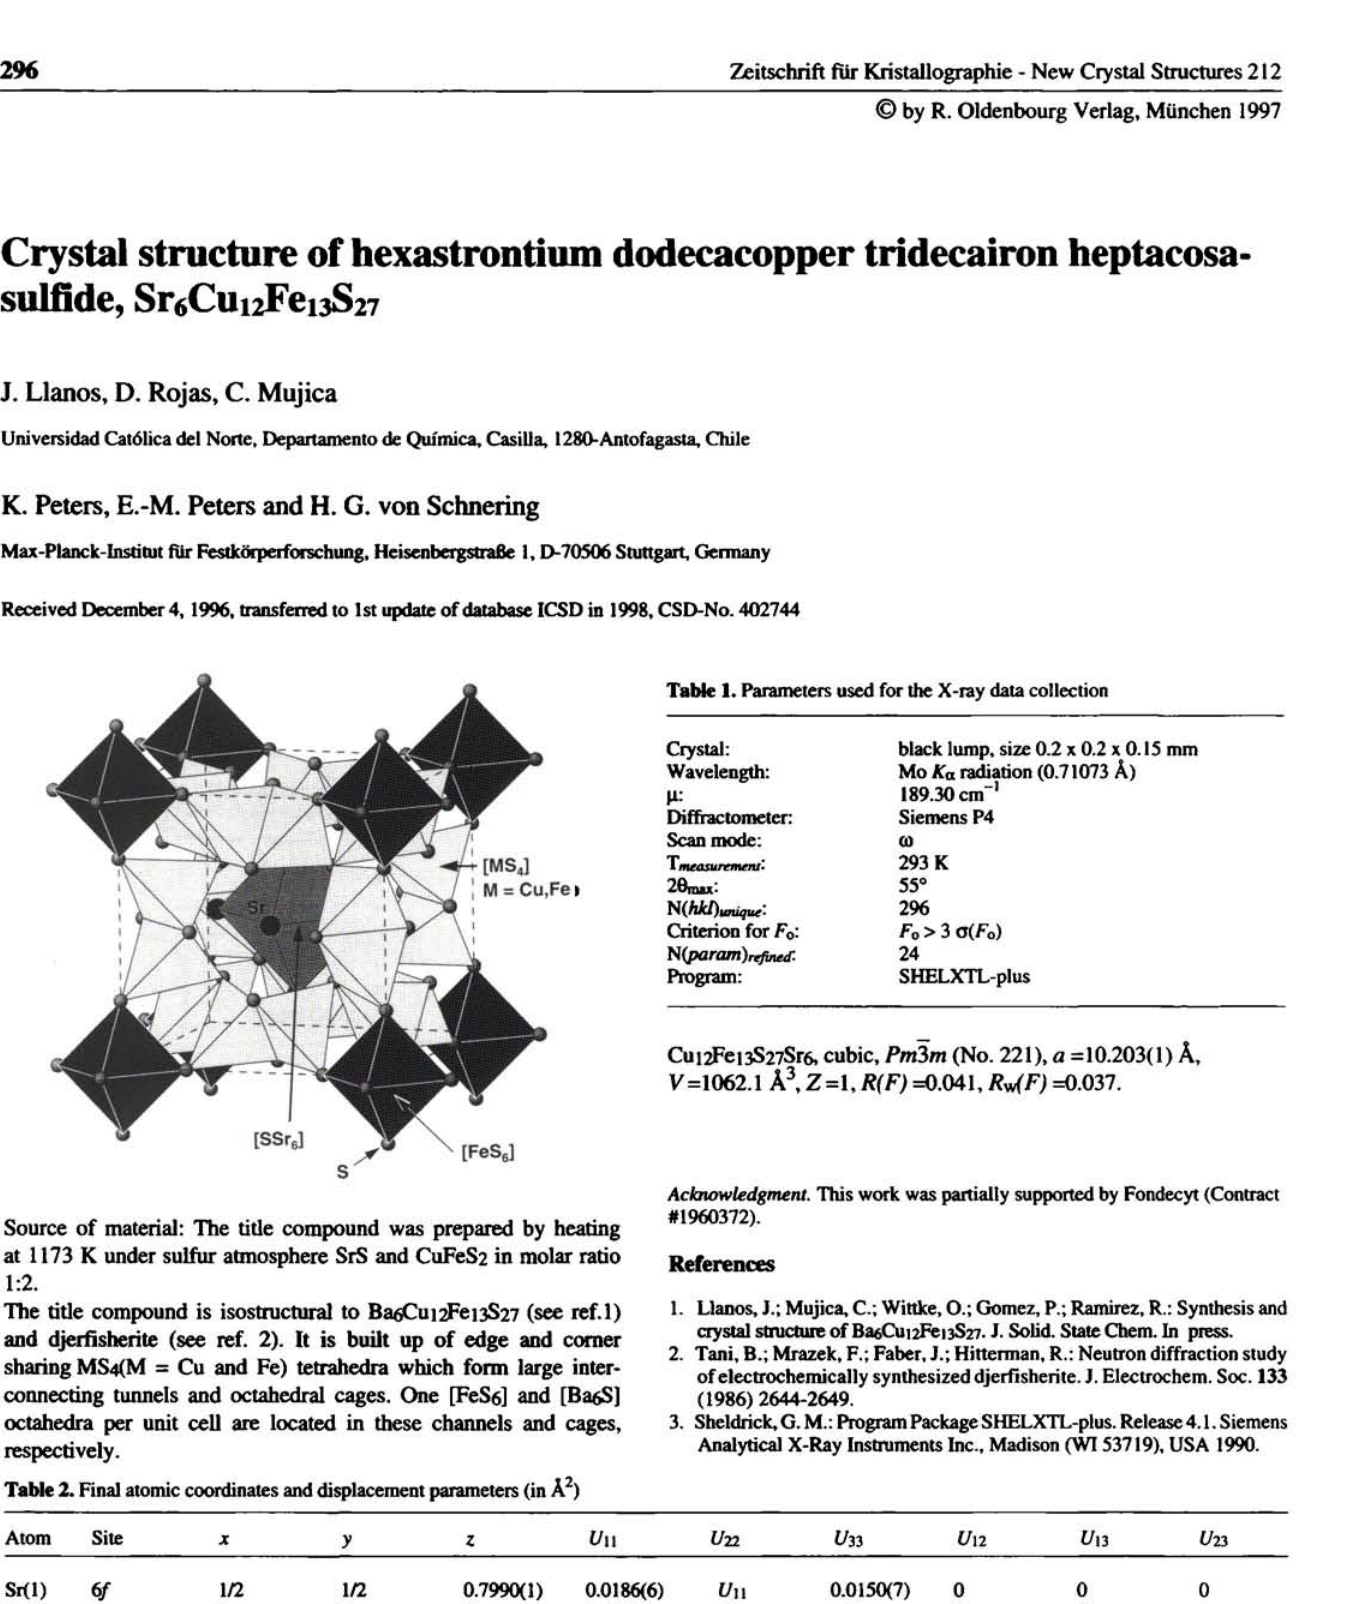
Table 2. Final atomic coordinates and displacement parameters (in Ä 2 )